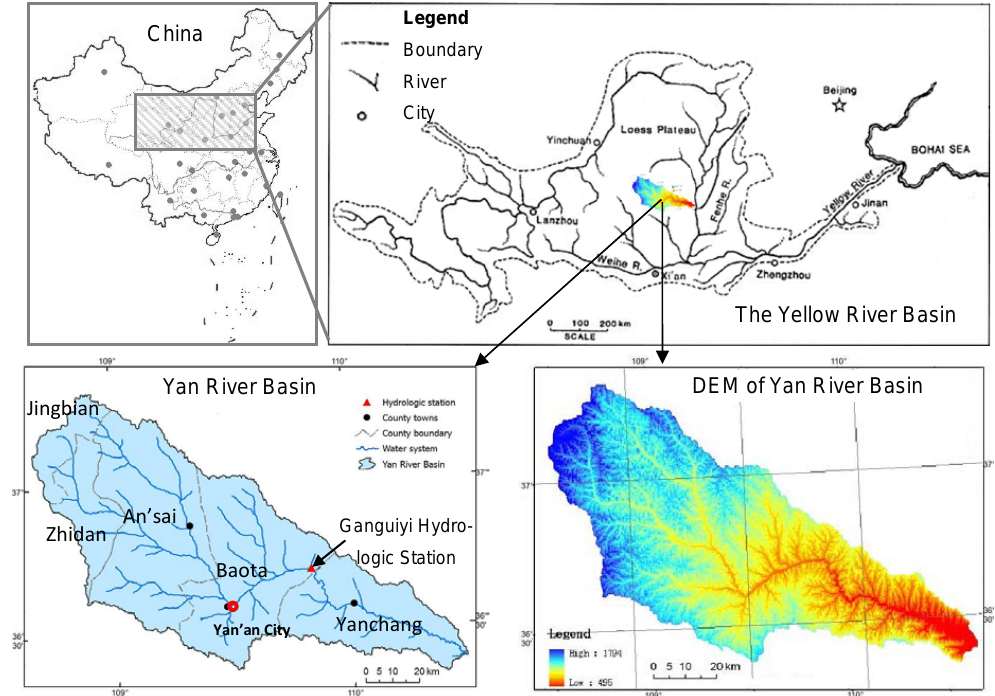
Fig. 1. Location of the study area (the Yan River Basin, China)